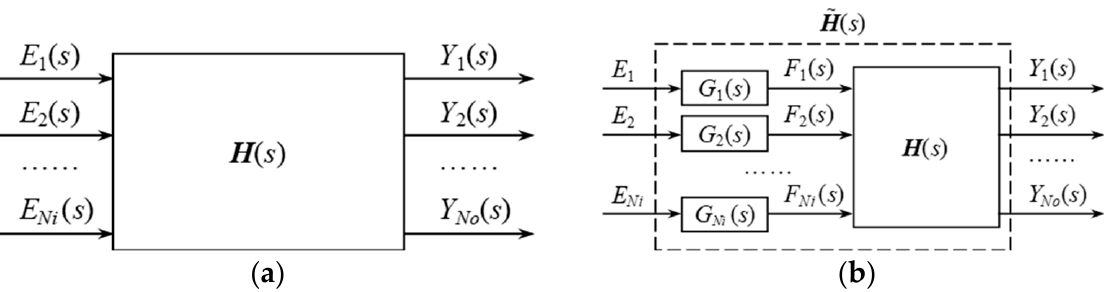
Figure 1. Input–output relation diagram of two types of structure: ( a ) random excitation; ( b ) contains periodic excitation.